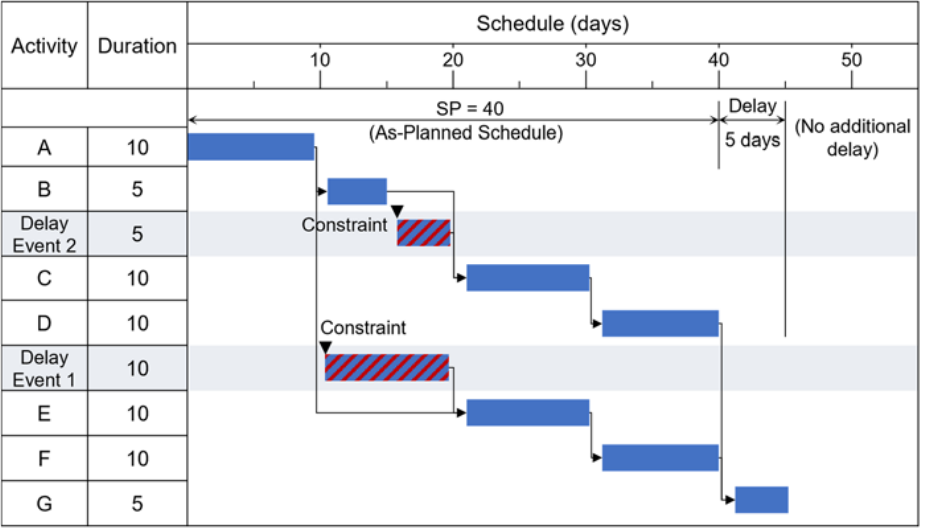
Figure 10. Adding delay events 1 and 2 by constraints.